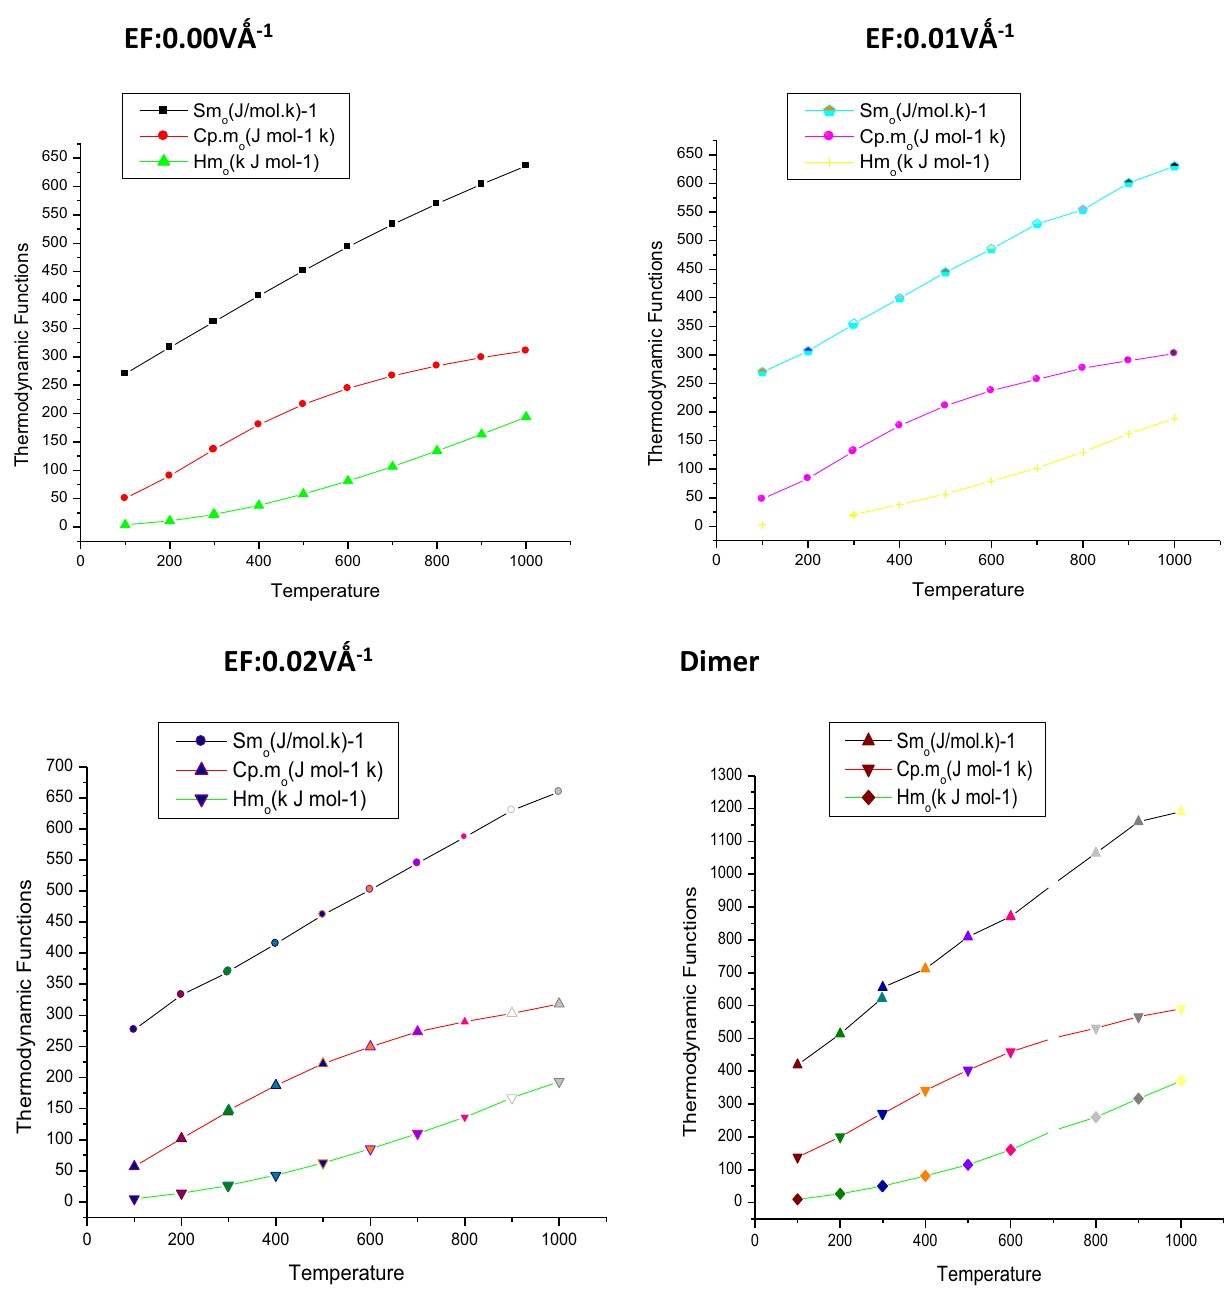
Fig. 17 Correlation graphic of entropy, enthalpy and heat capacity with various temperature of